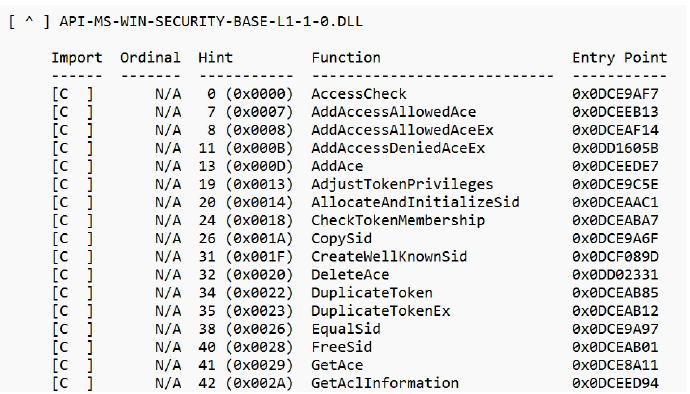
Figure 1. Static analysis output (excerpt).